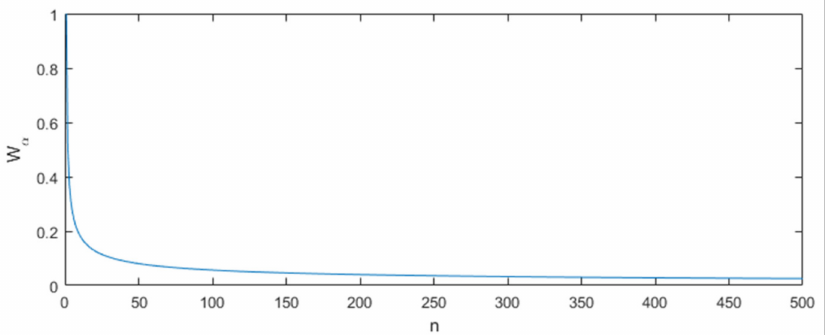
Figure 1. Summation of the approximated fractional-derivative filter terms ( W α ) as a function of the filter order, for α = 1/2